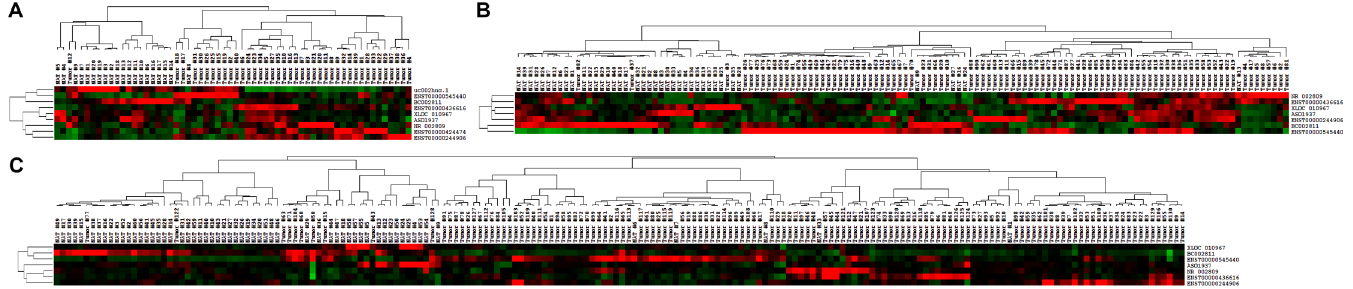
Fig 1. Cluster analysis of differentially expressed lncRNAs between astrocytomas and NAT samples. The lncRNA expression levels, as measured by qRT-PCR, were normalized, mean-centered, clustered, and plotted as a heat map for the training set (A), the validation set (B), and all samples (C). The dendrogram generated by the cluster analysis shows a clear separation of the astrocytoma and the NAT samples based on the 9 or 7 lncRNA profiles.